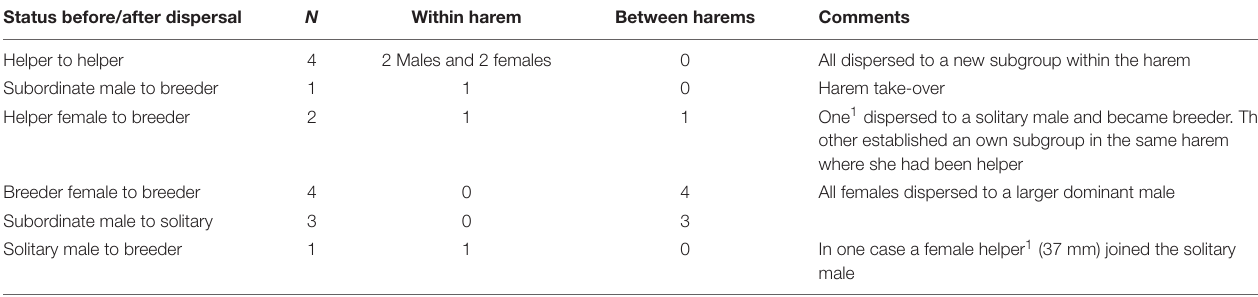
TABLE 2 | Recaptures and dispersal events recorded within a year.